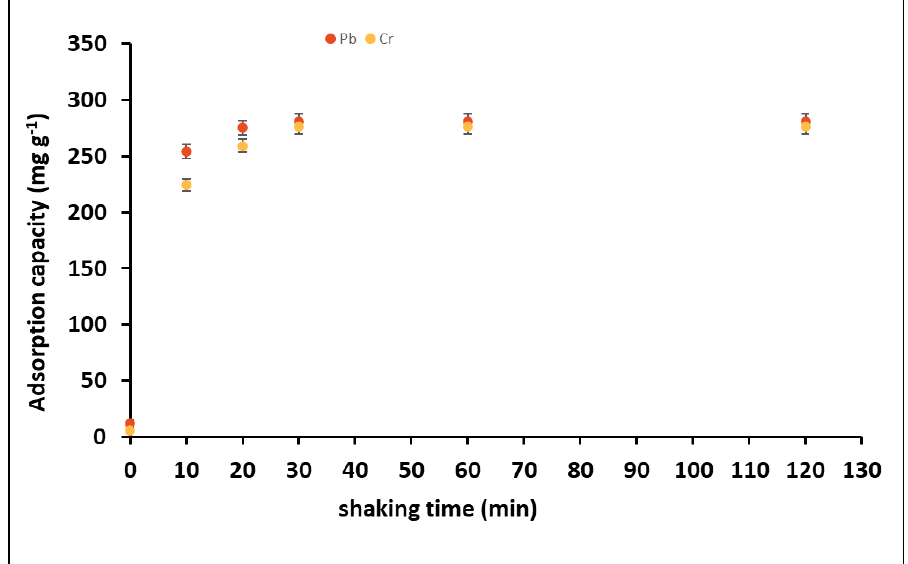
Figure 9. Sorption kinetics of Cr and Pb on GO-COOH.